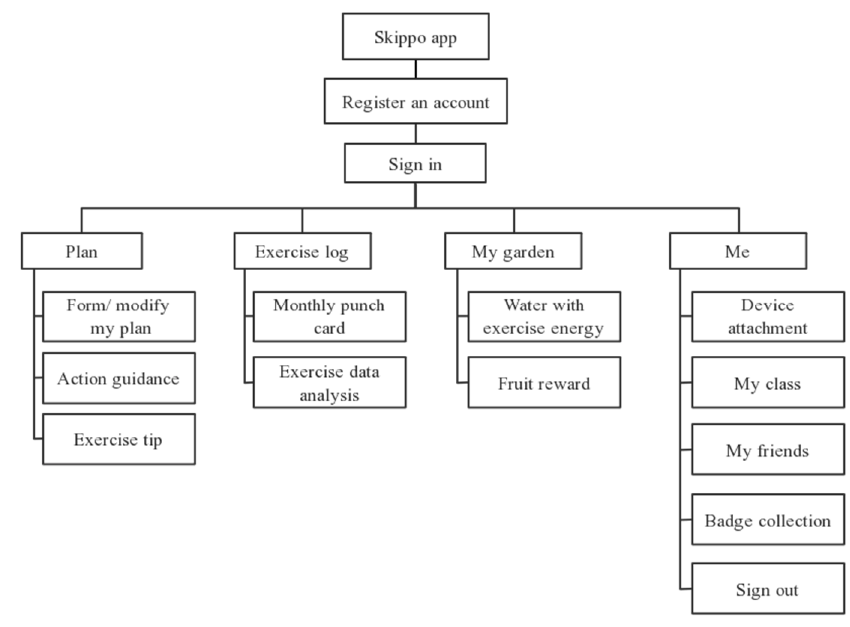
Figure 8. Software function flow chart.